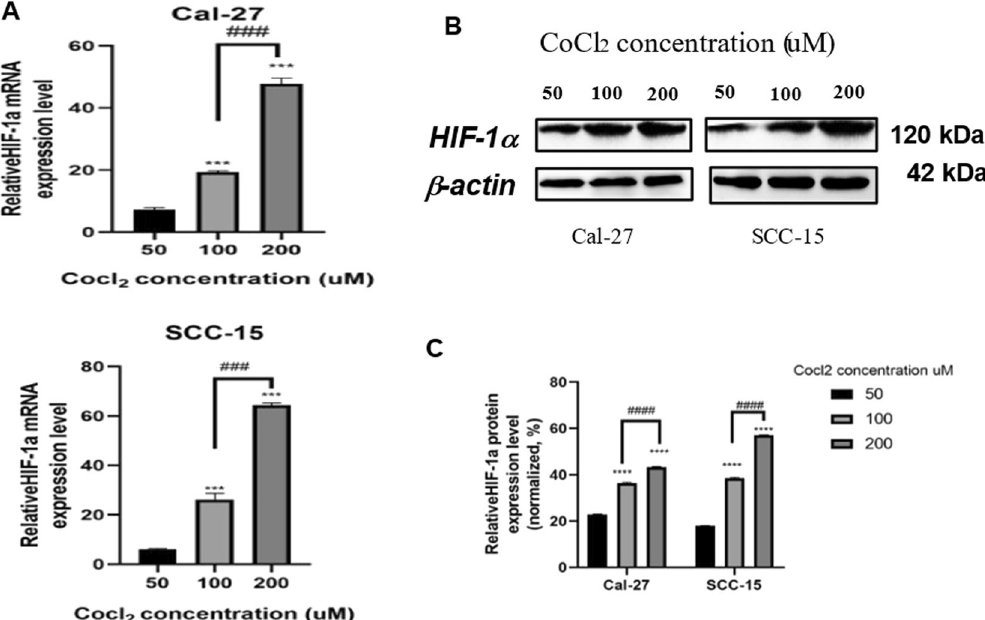
Fig. 3 CoCl 2 induced the mRNA and protein expression of HIF-1 α to construct a hypoxic microenvironment. CoCl 2 signi fi cantly induced the mRNA ( A ) and protein ( B ) and ( C ) expression of HIF-1 α in a dose-dependent manner. Cal-27 and SCC-15 cells were co-cultured with different concentrations of CoCl2 for 24 h, then the mRNA and protein expression levels of HIF-1 α were analyzed by qRT-PCR and Western blot, which were normalized to those of β -actin. Data were expressed as the mean ± SEM from three independent experiments. * p < 0.05, ** p < 0.01, *** p < 0.001 vs 50 μ M CoCl 2 ; # p < 0.05, ## p < 0.01, ### p < 0.001 vs. 50 μ M CoCl 2